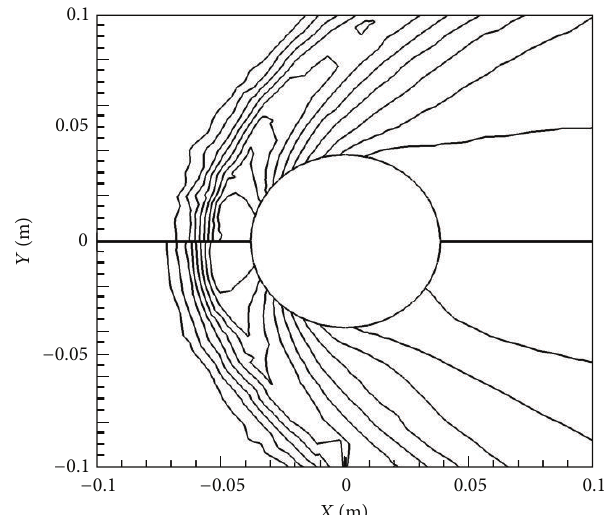
Figure 6: Comparison of density contours without magnetic field (top) and with 𝐵 max = 2 T oriented in 𝑋 -direction (bottom).